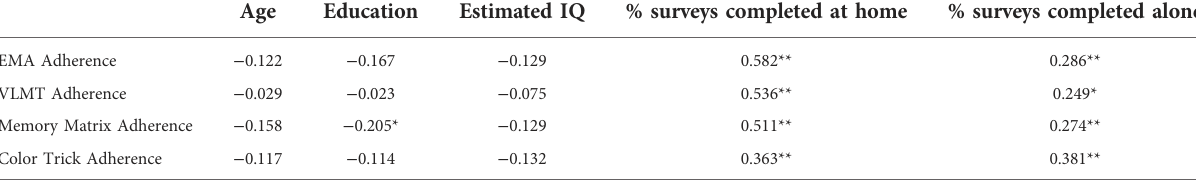
TABLE 3 Correlations between adherence and demographic characteristics in the whole sample ( N